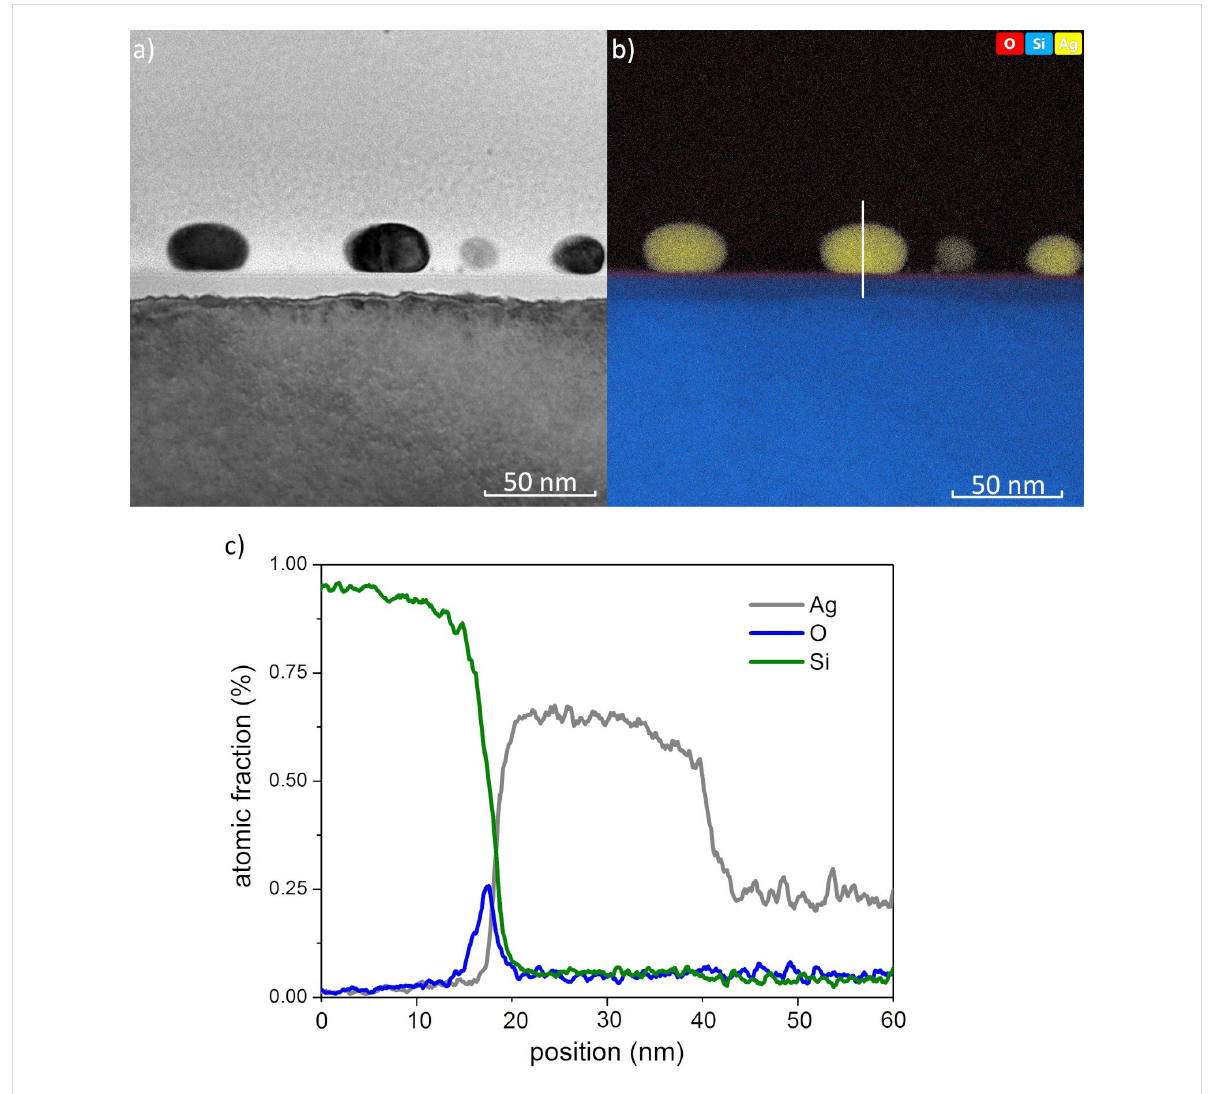
Figure 8: (a) HRTEM image of a cross section of a nanoisland formed from a 3 nm thick film, annealed at 550 °C for 15 min; (b) EDS analysis and (c) detailed EDS analysis of the cross section of the nanoisland.